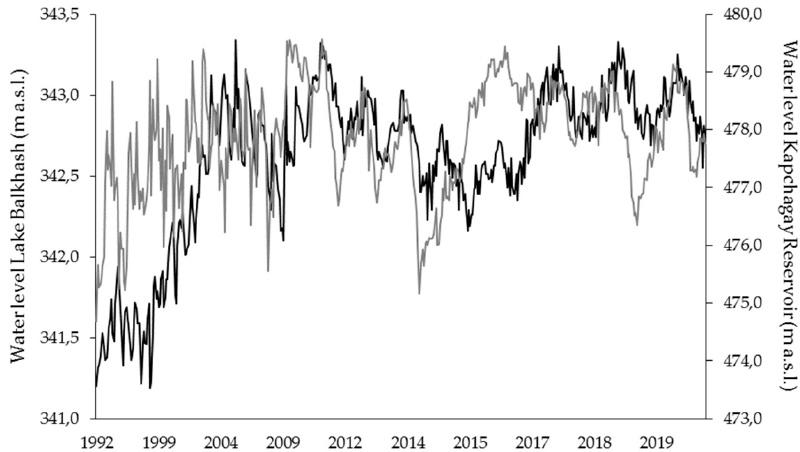
Figure 1. Water levels expressed in m above sea level (m a.s.l.) of Lake Balkhash (black) and Kapchagay Reservoir (gray), 1992–2019 (own presentation based on data by the authors of [45]). The Ili Delta is subjected to seasonal and annual water inflow changes. Seasonal changes include annual water runoff fluctuations of the Ili River, which are highest in spring and winter and lowest in summertime [21]. Long-term inflow changes were caused by the construction and filling phases of Kapchagay Dam over several years. Thus, water inflow changes to the Ili Delta and Lake Balkhash are not new. In recent decades, expansion of irrigated agriculture along river branches [5,20,22,23] and variations of snow masses in the Tian Shan Mountains that feed the Ili River [46] have affected water inflow and threatened the use and productivity of delta pastures [5,35]. 2.3. Linkage of Water Inflow and Reeds The spread of vegetation depends on water inflow of the Ili River because of the arid climate, with lowest average temperatures of –7.1 °C in January and highest of 25.2 °C in July and low average precipitation of 241.3 mm yr –1 [47]. Along the main river and channels, where groundwater levels are highest, vegetation is dominated by reed ( Phragmites australis ) as the main fodder plant for livestock keepers in the region [5,23,35,41]. Referring to Haeberlein & Kaiser [48], reed beds and grasses cover 11% (around 2900 km 2 ) of the total delta area. At river branches and Lake Balkhash, reed beds are dense and submerged; with increasing distance from water sources, reed beds become non- submerged and less dense [5]. Groundwater levels in such areas are between 1.5 and 2.5 m [49]. If the groundwater level is lower than 2.5 m, reeds and grasses are replaced by herbs and shrub vegetation [5,23]. Figure 2 shows an overview of the Ili Delta and the most important land cover classes for pastoral farming in 2014. Farms are distributed along the shore of Lake Balkhash, rivers, and small water channels, where reed beds occur. According to satellite-based analysis of Thevs et al. [5], in 2014, water bodies (excluding Lake Balkhash) covered 1002.08 km 2 . Submerged dense reeds were spread over an area of 854 km 2 (dark green area, Figure 2) and were not accessible for grazing or haymaking. The extent of non-submerged dense reed was 1263.78 km 2 (light green area, Figure 2) and was the main important class for pastoral farming. These areas are highly productive and usable for grazing and haymaking. The largest area, with 1384 km 2 , was covered by open reed and shrub vegetation. At these sites, the water level is below 2.5 m [5] and reed productivity is low. Therefore, they are suitable for grazing but not for haymaking [5,35].